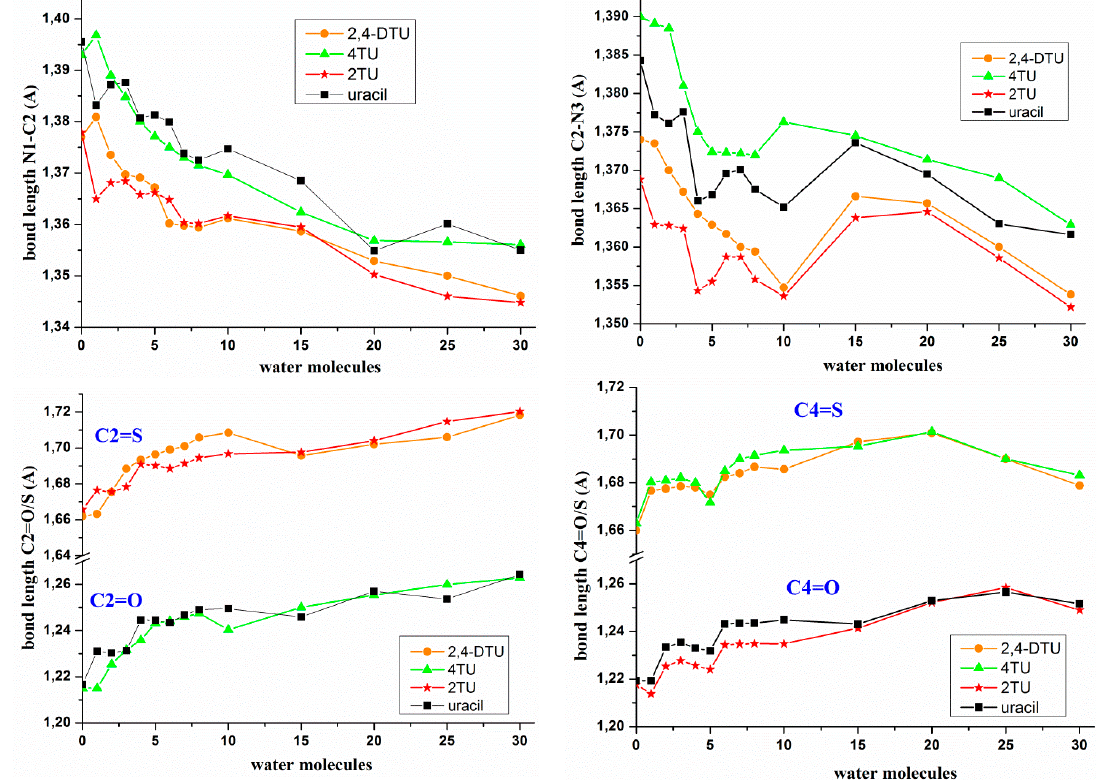
Figure 4. Changes observed in the most characteristics bond lengths of the nucleobase with the increase of the number of water molecules of hydration. Comparison of the values of uracil versus 2-thiouracil, 4-thiouracil and 2,4-dithiouracil molecules. The results were calculated at the B3LYP/6–31G(d,p)